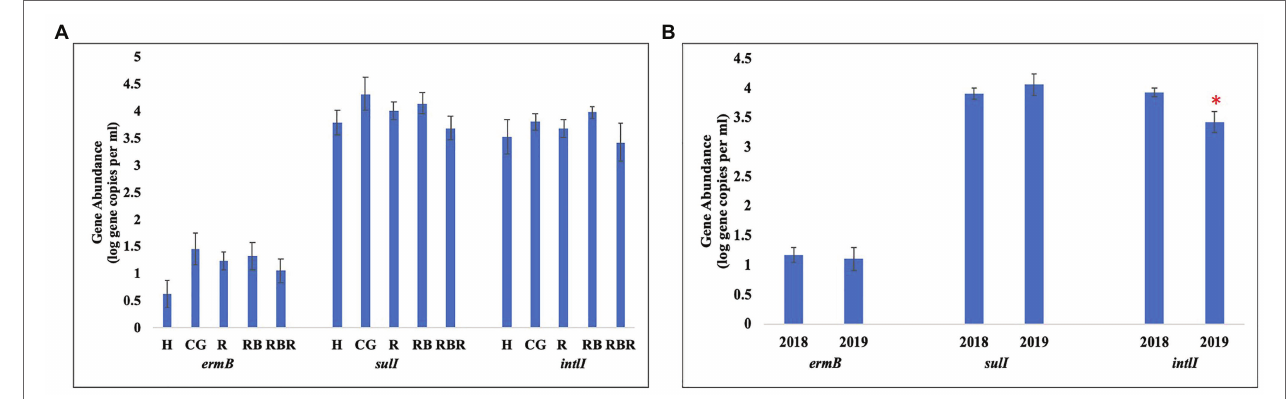
FIGURE 5 | Mean abundances of three AMR associated genes, ermB , sulI , and intlI amplified from water genomic DNA samples based on (A) pasture management (H, CG, R, RB, and RBR), (B) sampling year (2018 and 2019). Treatments included: hayed (H), continuously grazed (CG), rotationally grazed (R), rotationally grazed with a buffer strip (RB), and rotationally grazed with a fenced riparian buffer (RBR). Error bars represent standard errors. The star indicates a significant difference at an alpha level of